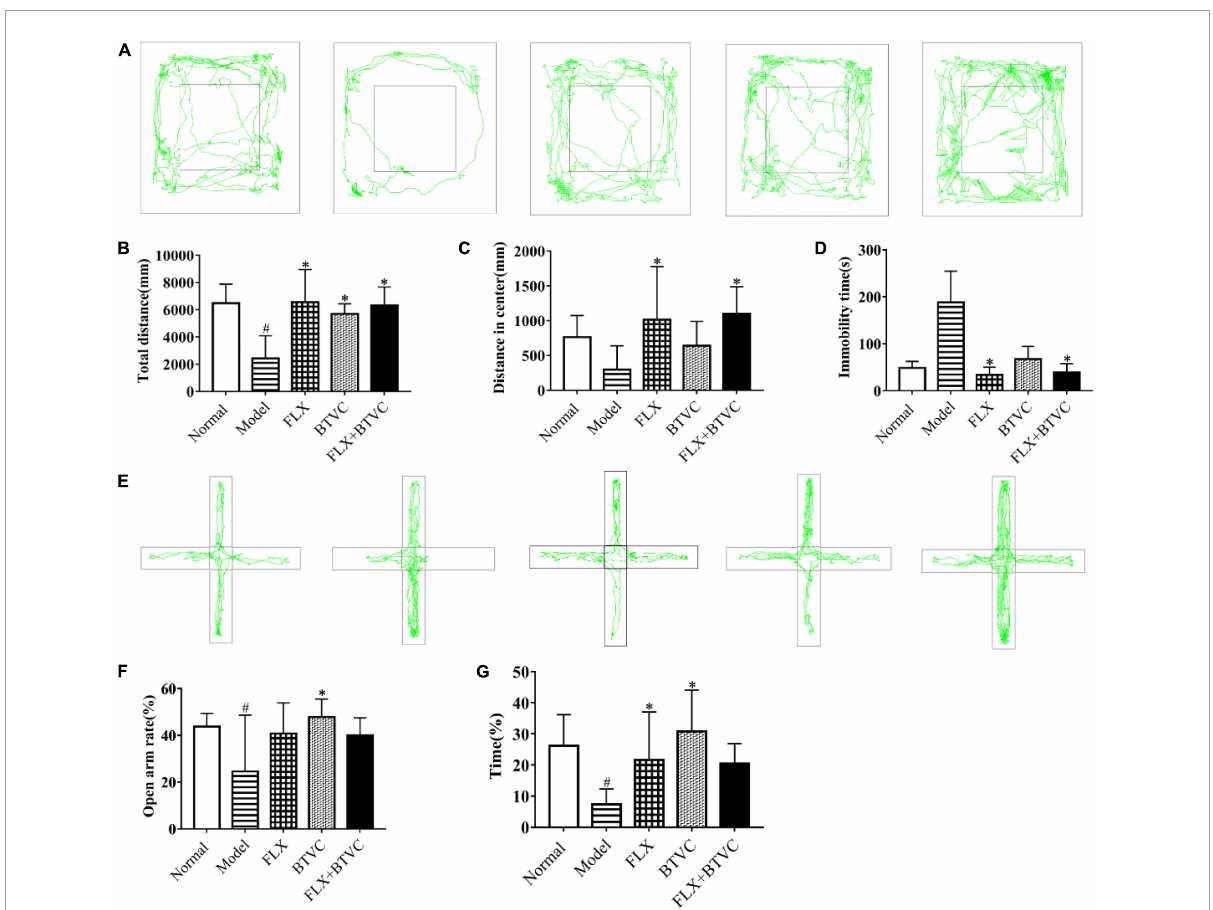
FIGURE2 Behavioural test, (A–D) the open field test, (E–G) the elevated plus-maze test. Representative figure of rats’ tracks (A) , the total distance travelled (B) , the distance travelled in the central area (C) , immobility time in the open field test (D) . The movement trajectory of each groups in the elevated plus-maze, the vertical arms are closed arms, the horizontal arms are open arms, and the middle is the central area (E) , the ratio of the number of times the rats in each group enter the open arm in the elevated plus-maze (F) , the time ratio of staying in the open arm in the elevated plus-maze (G) . Compared with the Normal group, # P < 0.05; compared with the Model group,* P <